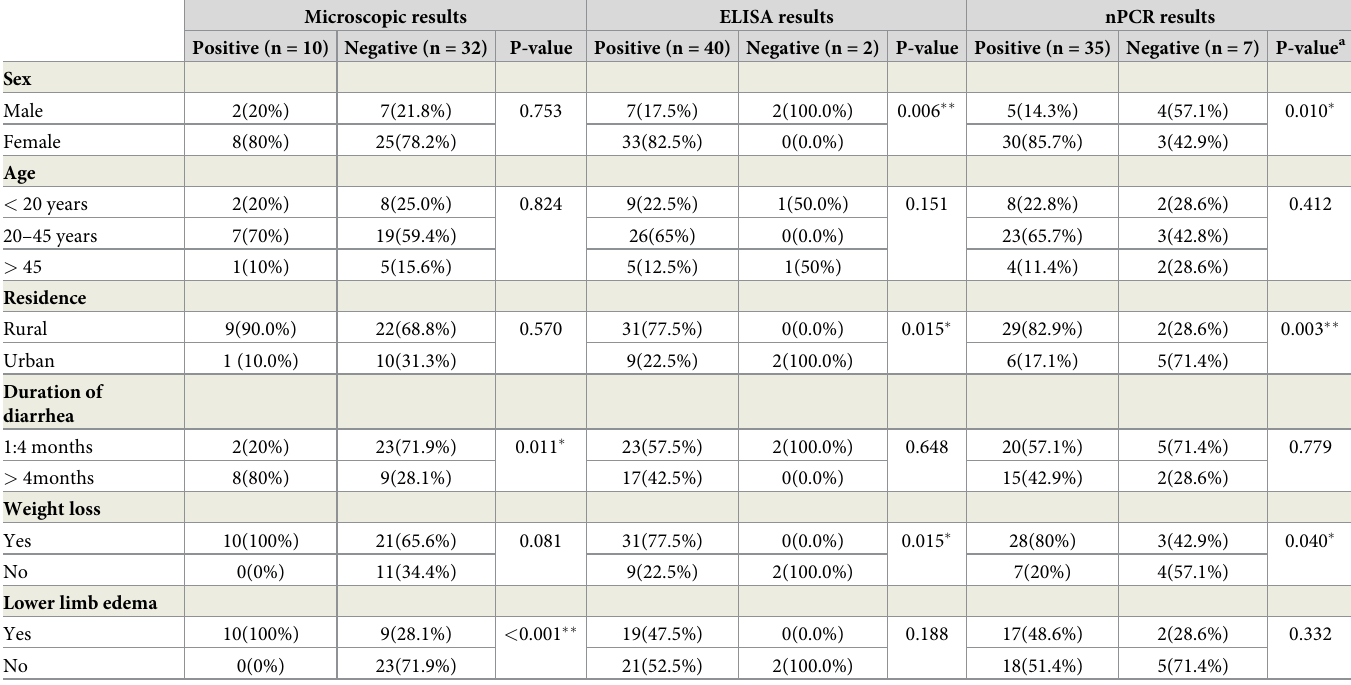
Table 3. Correlation between sociodemographic characteristics and clinical data and the microscopic, ELISA, and PCR results among the study. Microscopic results ELISA results